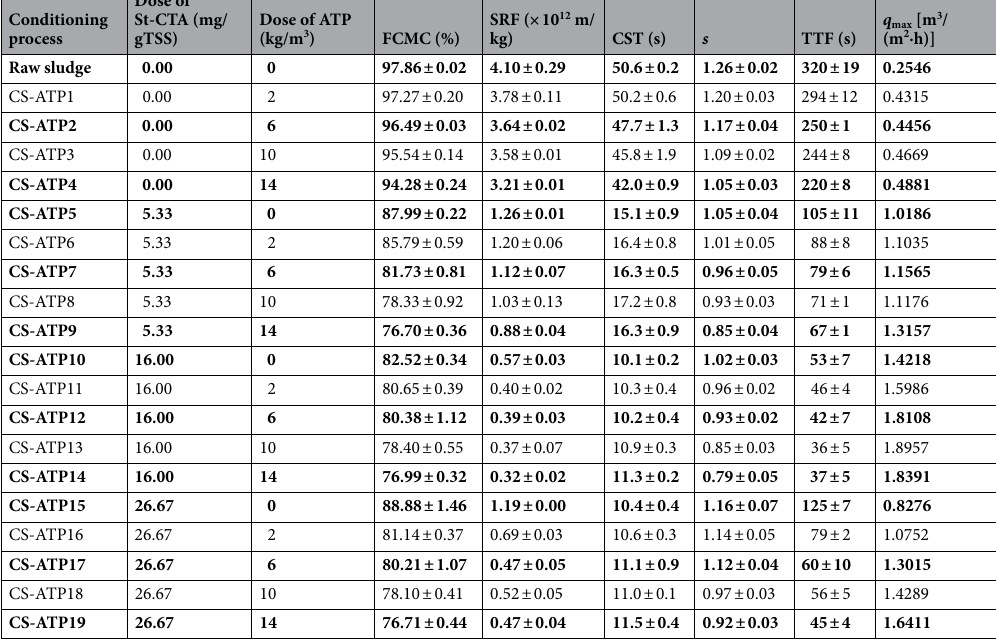
Table 1. Sludge dewatering performance of St-CTA in conjunction with ATP by using different doses (the samples colored in bold in this table would be applied in the following experiments).